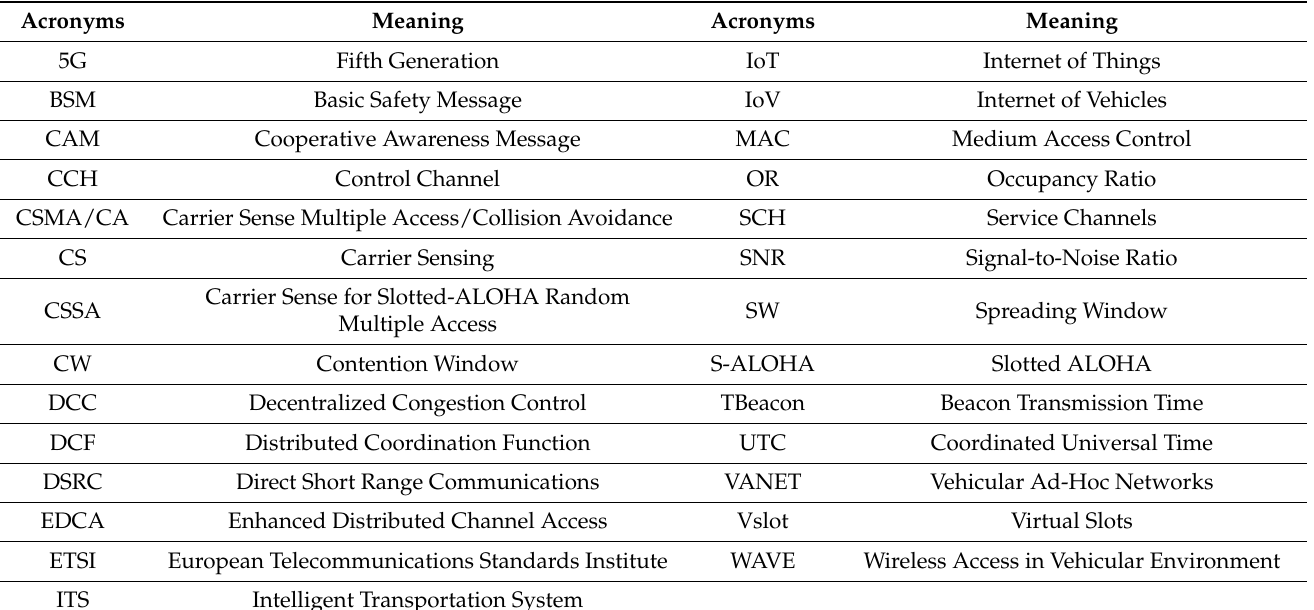
Table 1. List of used